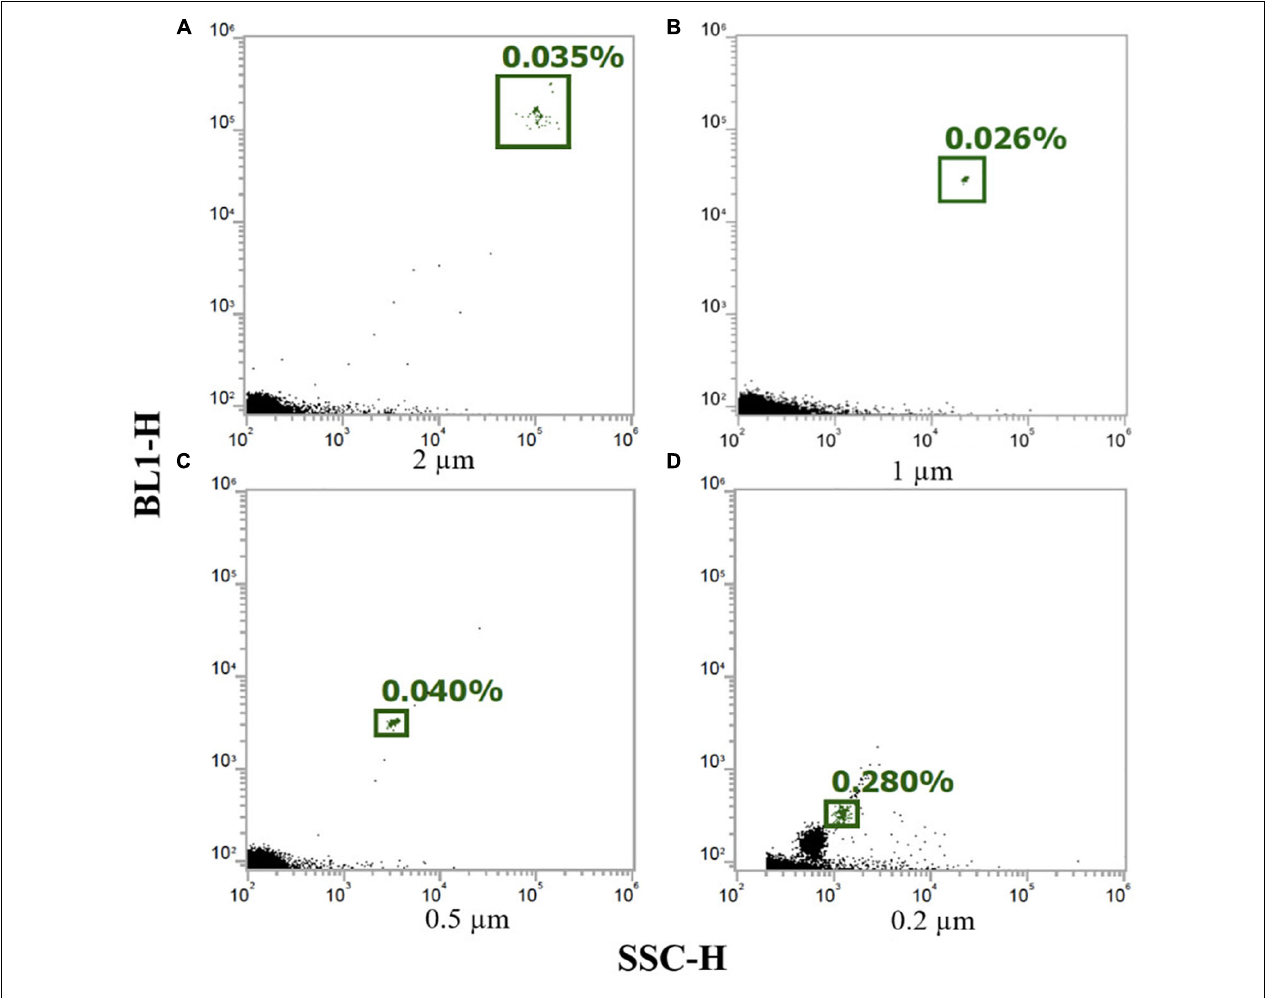
FIGURE 4 | Flow cytometry dot plots for the plastic size beads from the reference kit, (A) 2 µ m, (B) 1 µ m, (C) 0.5 µ m, and (D) 0.2 µ m. The green-gated populations represent the size beads and the black particles the background (particles smaller than 0.2 µ m were not distinguishable from the background noise).